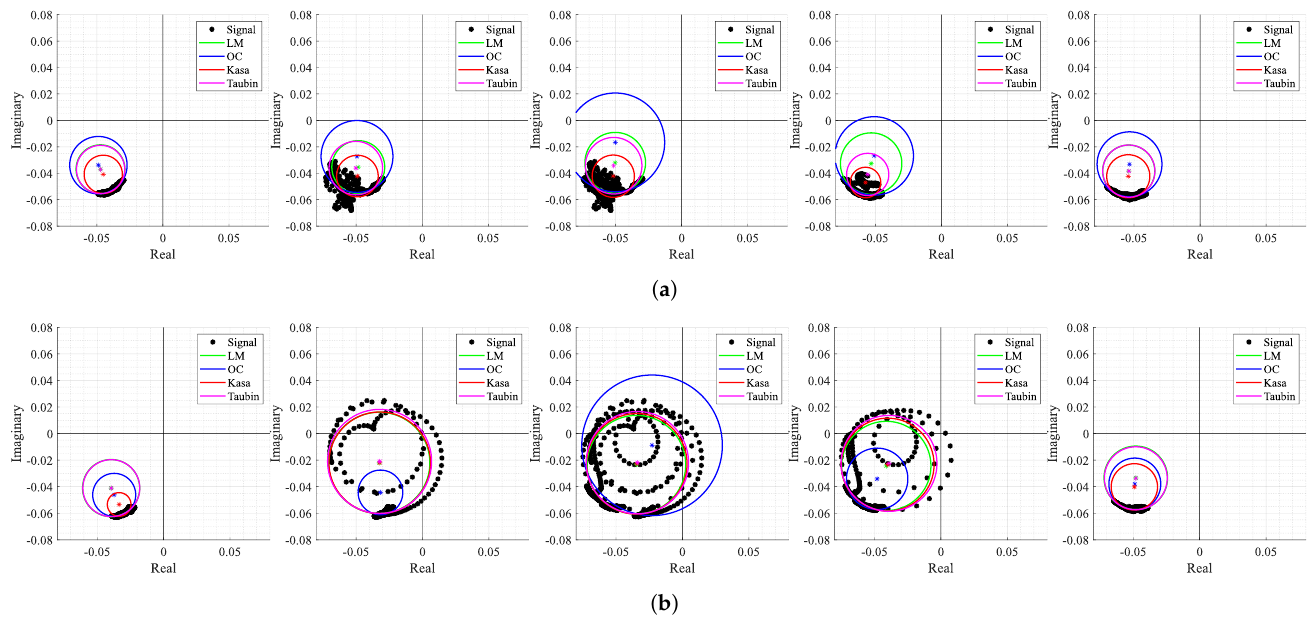
Figure 19. Circle fitting result over time for case 4: ( a ) Windows 18 to 22 containing the motion of an arm raising up to the head, ( b ) Windows 53 to 57 containing the motion of the body moving forward and backward with respect to the